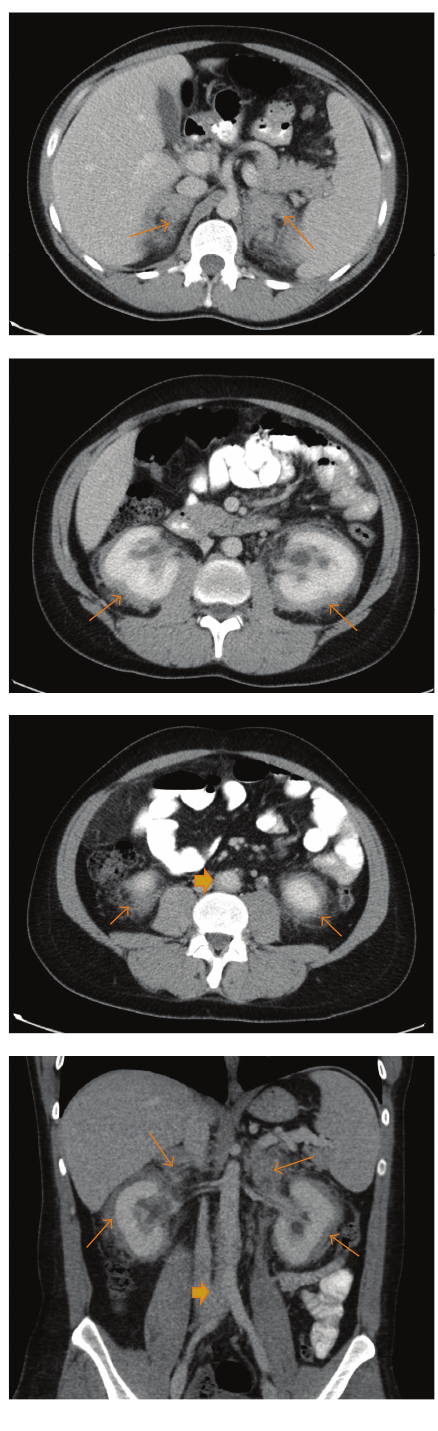
Figure 10: A 35-year-old male with axial and coronal reformatted contrast-enhanced CT images of the abdomen and pelvis showing enhancing soft tissue infiltration of the adrenal glands and kidneys (hairy kidney appearance) bilaterally (thin arrows). This is causing constriction of the renal pelvis and proximal ureters resulting in hydronephrosis. There is also retroperitoneal soft tissue infiltration (thick arrow) covering the posterolateral aorta (coated aorta appear- ance) which extends from just below level of renal arteries to aortic bifurcation and proximal right common iliac